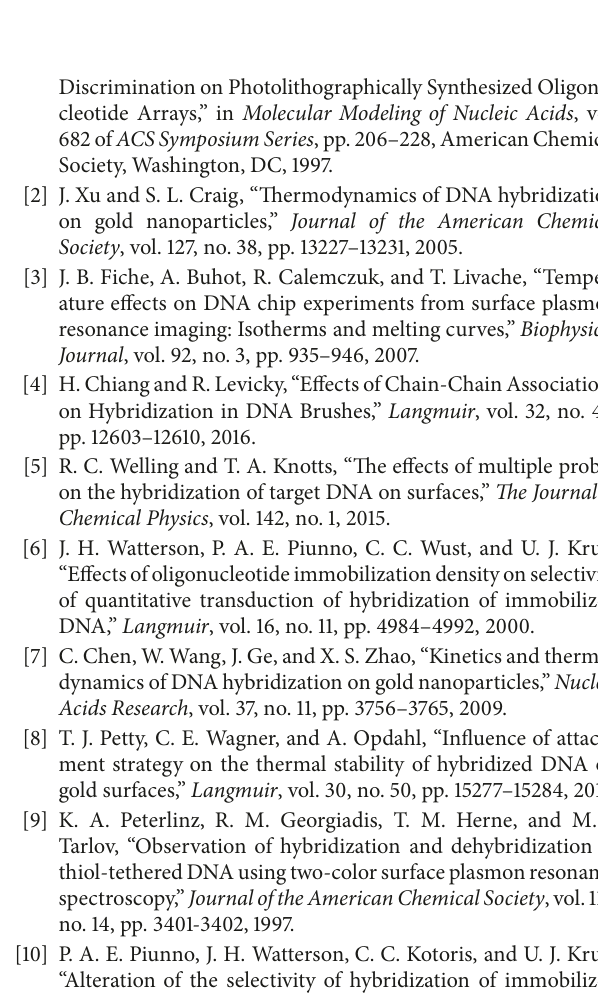
Figure 7: A sample melting curve measured on a DNA monolayer immobilized to a BMDPM-crosslinked PMPMS film. The probe sequence is 5 󸀠 -ATG ATG ATG CAG TGT GAG TT-3 󸀠 , which was also used in the thermodynamic studies of reference [4]. Inserted: CV curve at 𝑇 = 305